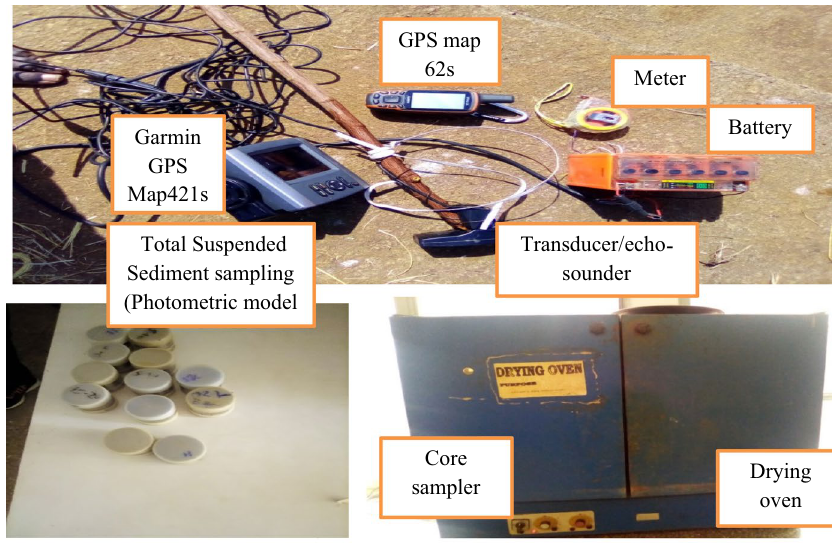
Fig. 3 Photograph of material used at field and laboratory taken during